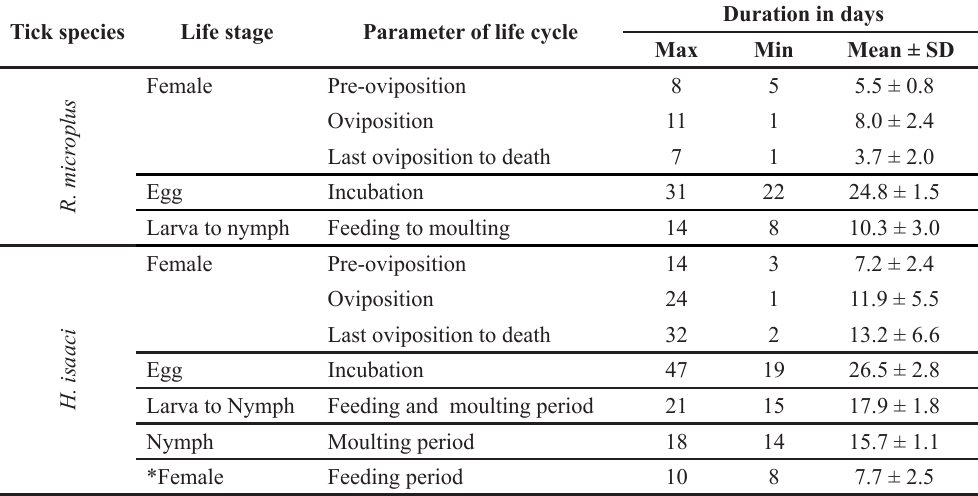
* indicates the adults (females) which were raised in the laboratory